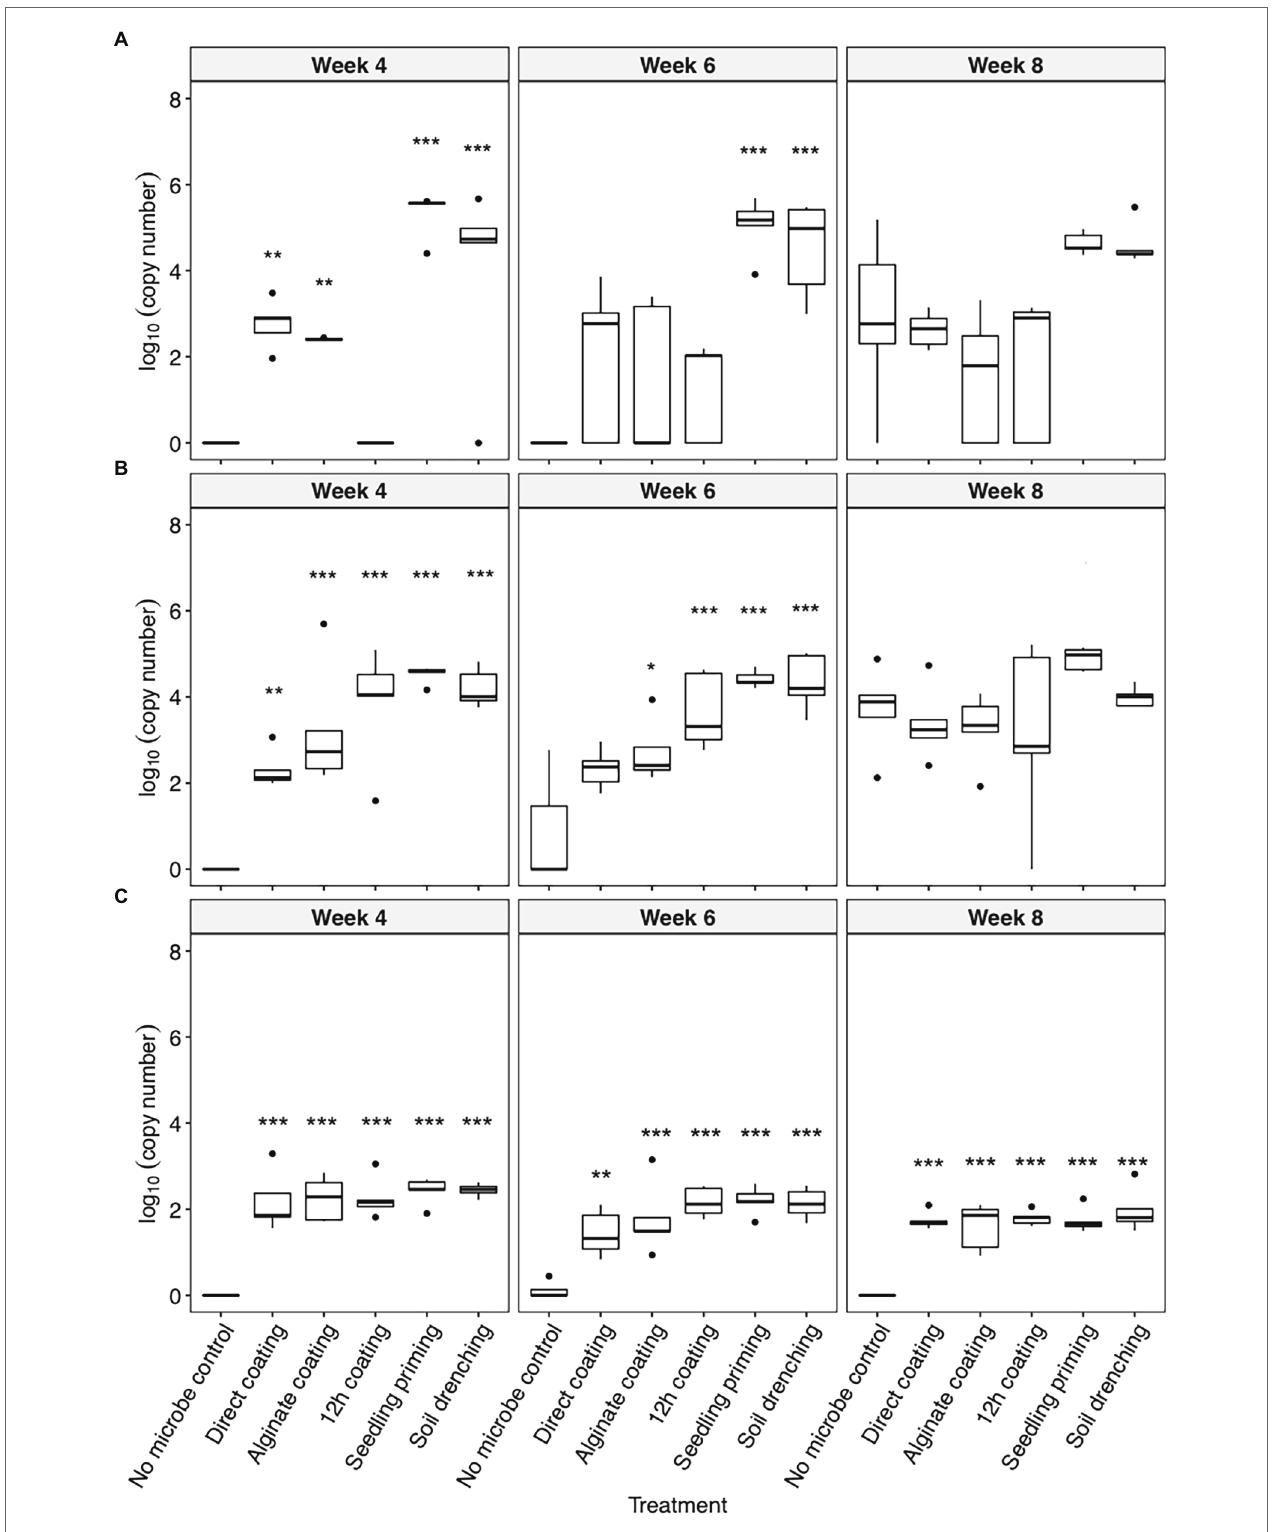
FIGURE 1 | The colonization [log 10 (bacterial DNA copy number)/ng of rhizosphere DNA] of (A) Caulobacter rhizosphaerae , (B) Chitinophaga pinensis , and (C) Terrabacter sp. in the rhizosphere of Sorghum bicolor inoculated using different methods at week 4, 6, and 8 after planting. ANOVA was performed with Tukey’s HSD correction for multiple comparisons. Asterisks denote significant difference in the bacteria DNA copy number between inoculated samples and uninoculated controls. * p ≤ 0.05, ** p ≤ 0.01, *** p ≤